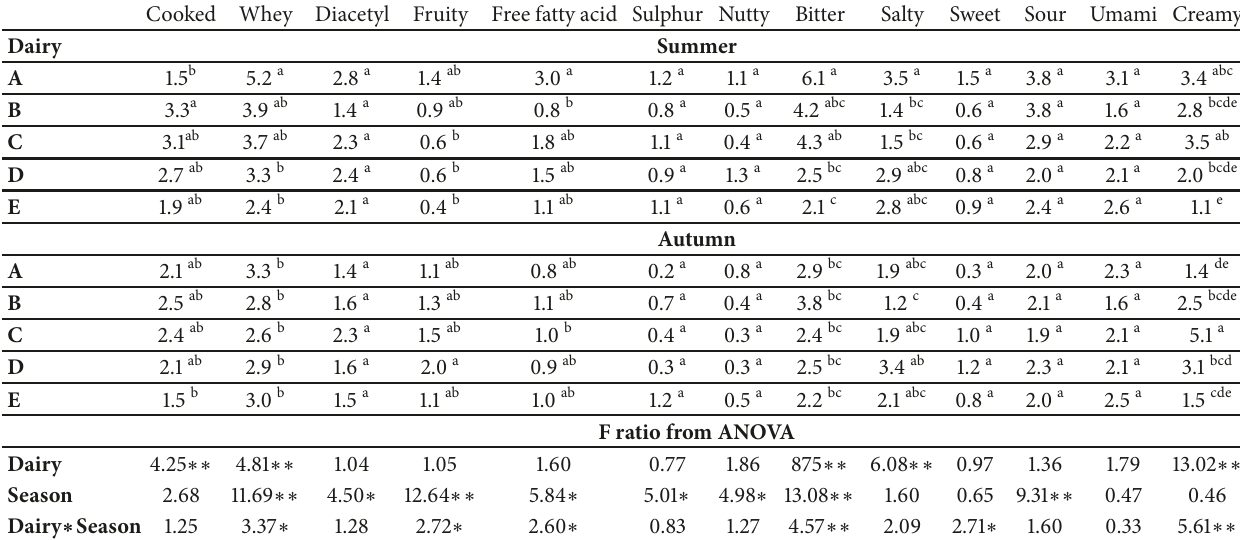
Table 2: Effect of dairy and sampling season on the sensory scores of Chihuahua cheese